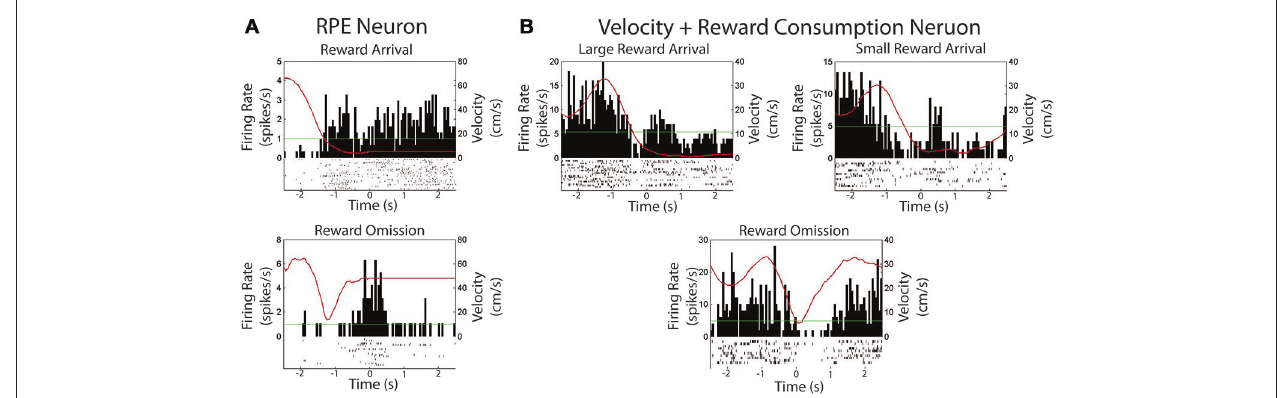
FIGURE 5 | Two neurons were found to be modulated by reward in experiment 1. (A) Session summary of a neuron which met criteria for a reward prediction error neuron. Top: Firing rate on arrival at expected reward. Bottom: Firing rate on arrival at an unexpectedly omitted reward. (B) Session summary of neuron which correlated with velocity and reward consumption as shown when consuming a large or small reward or when reward is unexpectedly omitted. The green line is the session average firing rate for each neuron. The red line is the average velocity of the rat across the peri-event time